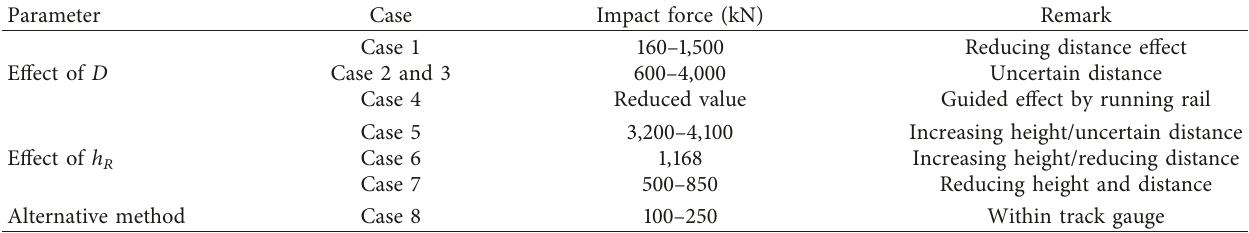
Table 5: Summary for the effects of the containment